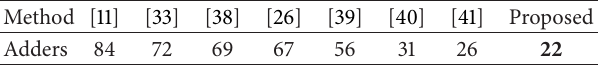
Table 7: Macrostatistics of 1D-DCT implementation.